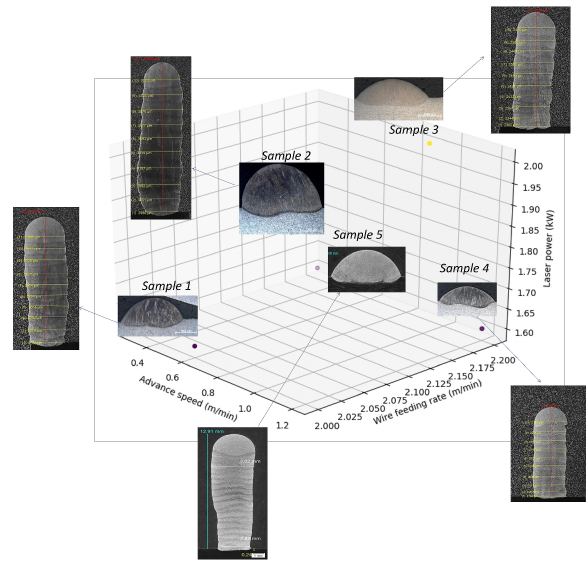
Figure 12. Bead geometry